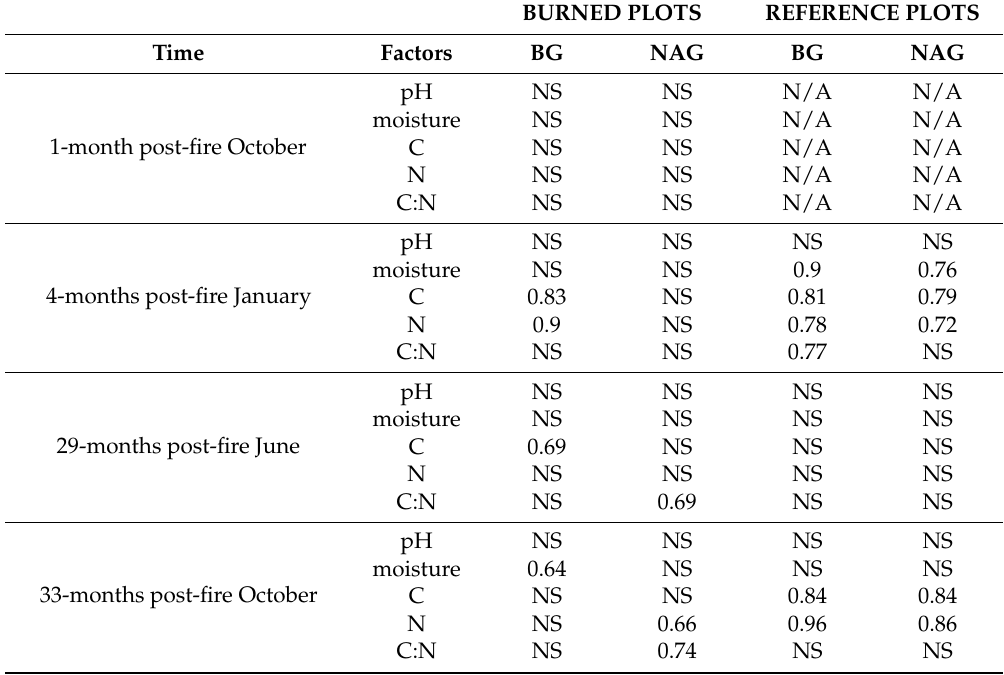
Table 2. Correlations between β -1,4-glucosidase (BG) and β -1,4- N -acetylglucosaminidase (NAG) enzyme activity and edaphic properties. Significant ( p < 0.05) correlations (Pearson’s r) shown for burned and reference soils across all time